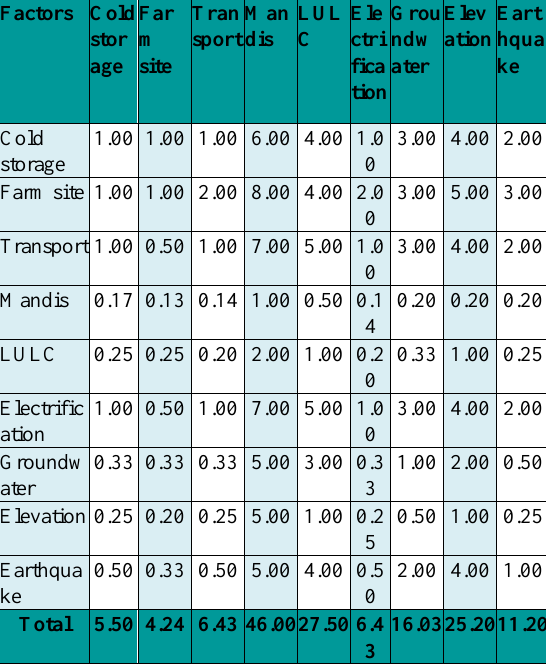
Table 4. Calculation of weights of